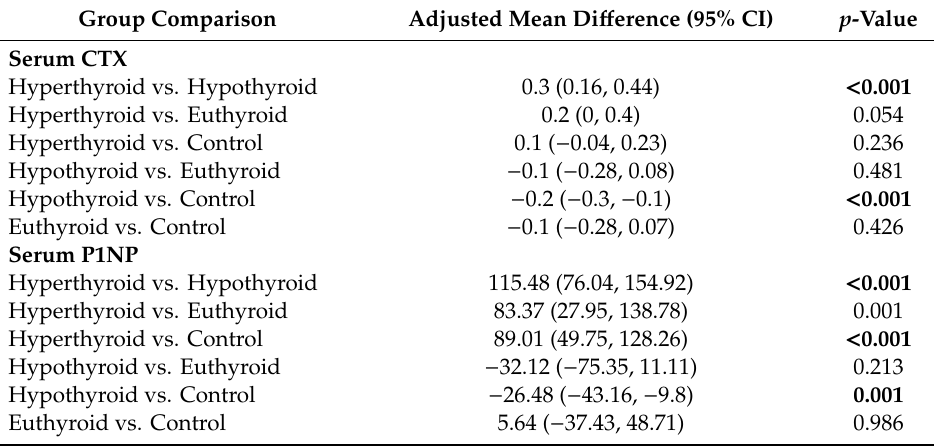
Table 10. Pairwise comparison of mean bone turnover markers in between groups (ANOVA). Multiple comparisons using Games–Howell